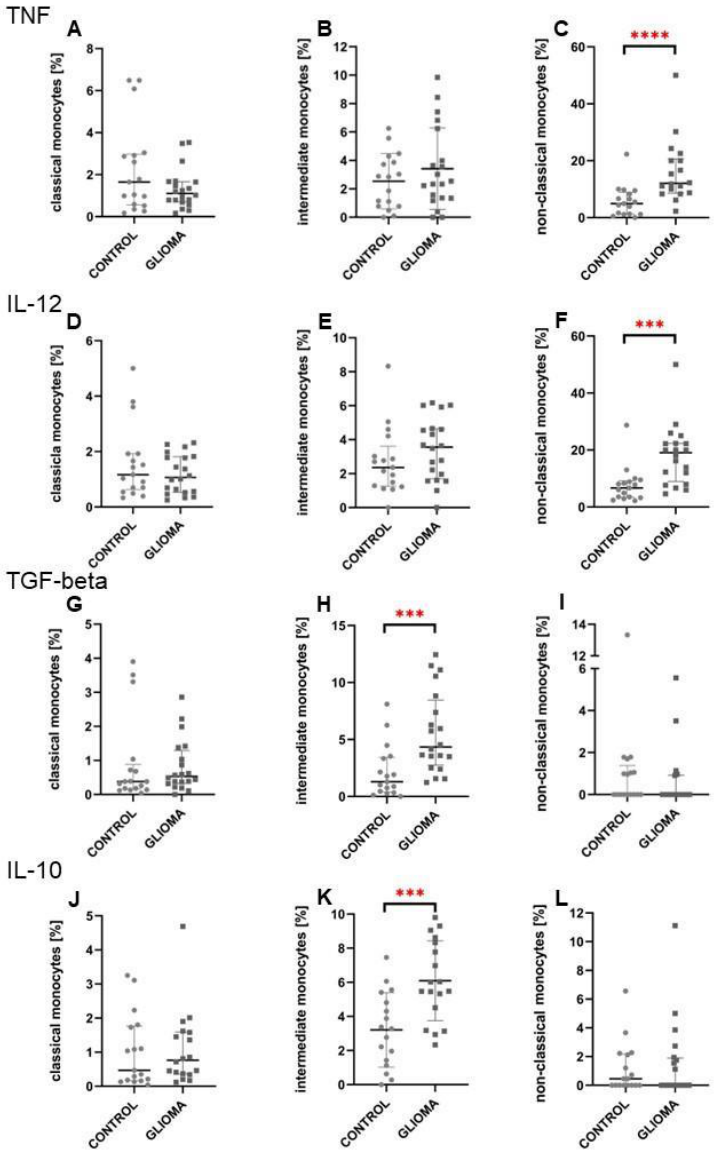
Figure 5. The results of cytokine molecules ’ expression for three monocyte subpopulations com- pared to the healthy volunteers ’ group. Both, pro-inflammatory TNF, IL-12 ( A – C ; D – F , correspond- ingly) and anti-inflammatory TGF-beta, IL-10 ( G – I ; J – L , respectively) were evaluated. Unpaired t - student was used for the statistical test, the results of which are presented in graph ( B , K ). In other